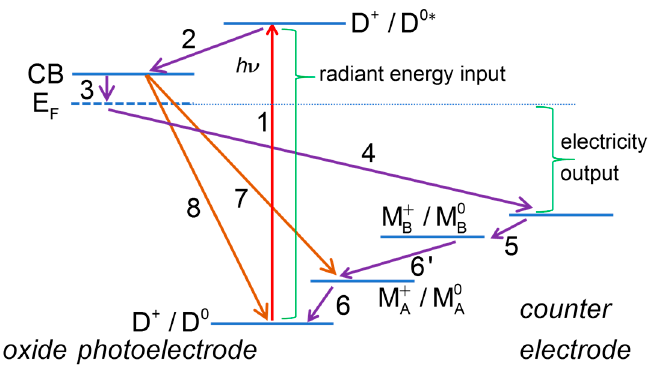
Figure 13. Energy diagram of a dye-sensitized solar cell with a dual mediator-containing electrolyte. Processes (1–5) and (7–8) are analogous to those in Figure 1. Process (6) corresponds to the reaction between mediator M + / M 0 B and co-mediator M + / M 0 A , species interacting with the CE and the B A photoelectrode,